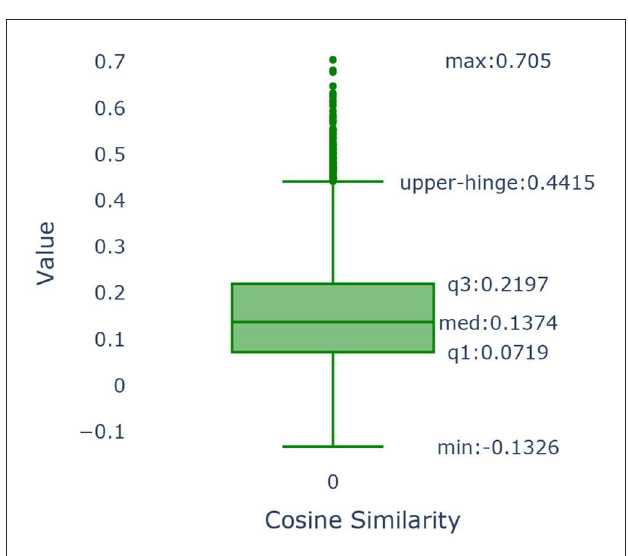
FIGURE10 Boxplot of the cosine similarities between the embedding vectors of “category, subcategory 1, subcategory 2, subcategory 3 and the definition” and “PhenX categories”.